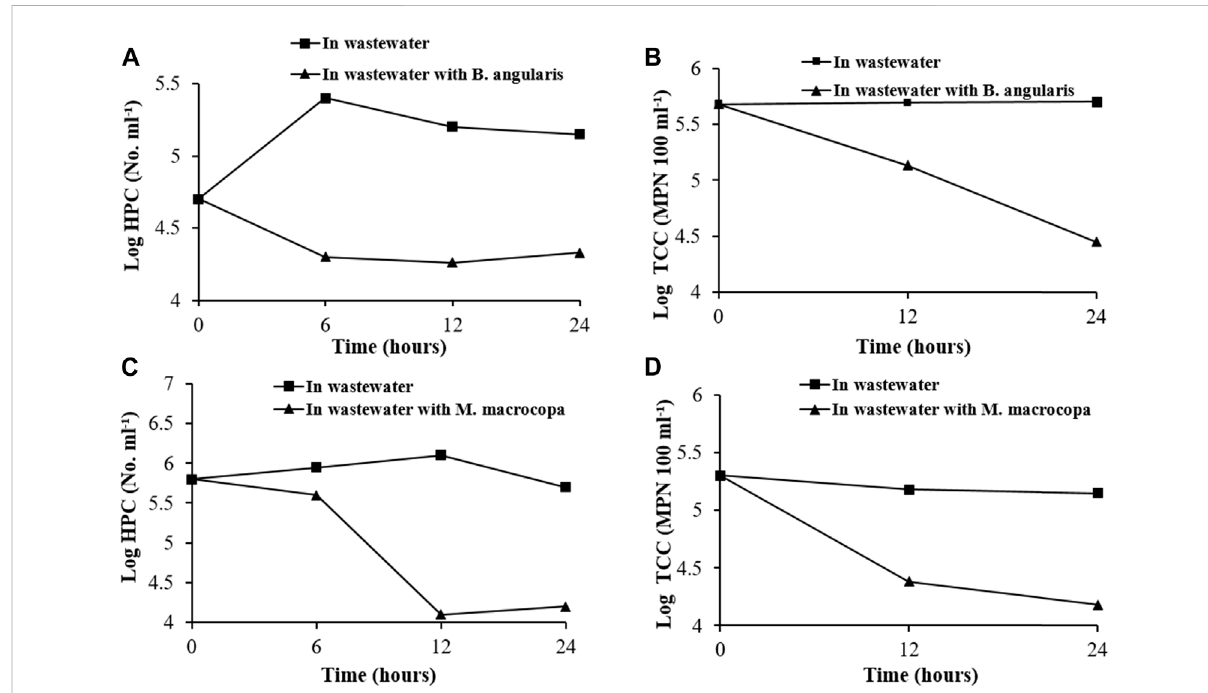
FIGURE 9 Bactericidal potential of Gangetic bio fi lters in wastewater. B. angularis driven bacterial population decline in (A) HPC & (B) TCC. M. macrocopa driven bacterial population decline in (C) HPC and (D) TCC. (HPC, Heterotrophic Plate count; TCC, Total Coliform